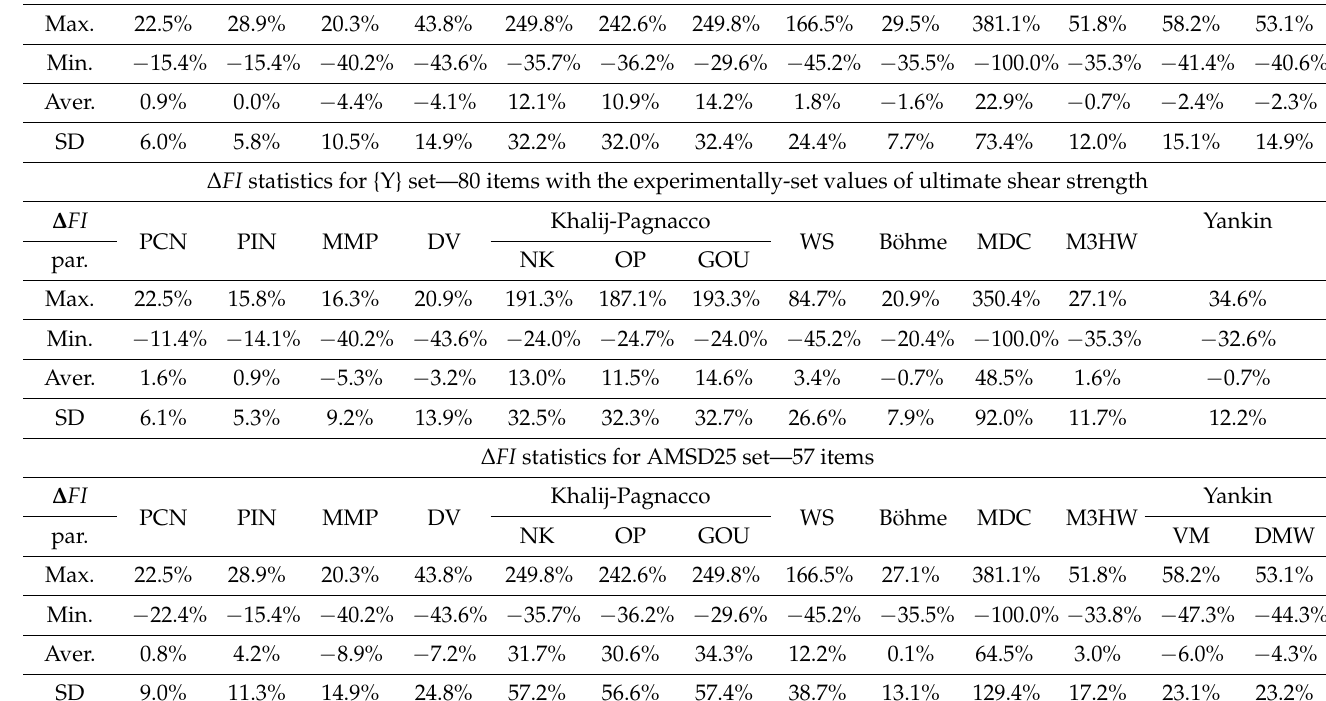
∆ FI statistics for AMSD25 set—57